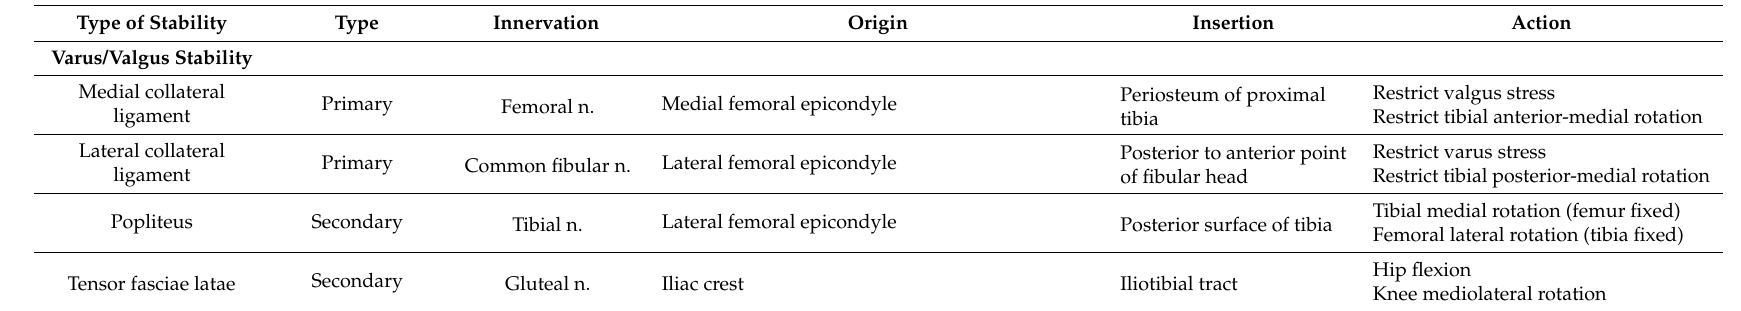
Abbreviations: n = nerve, AP = Anterior-posterior, PA =